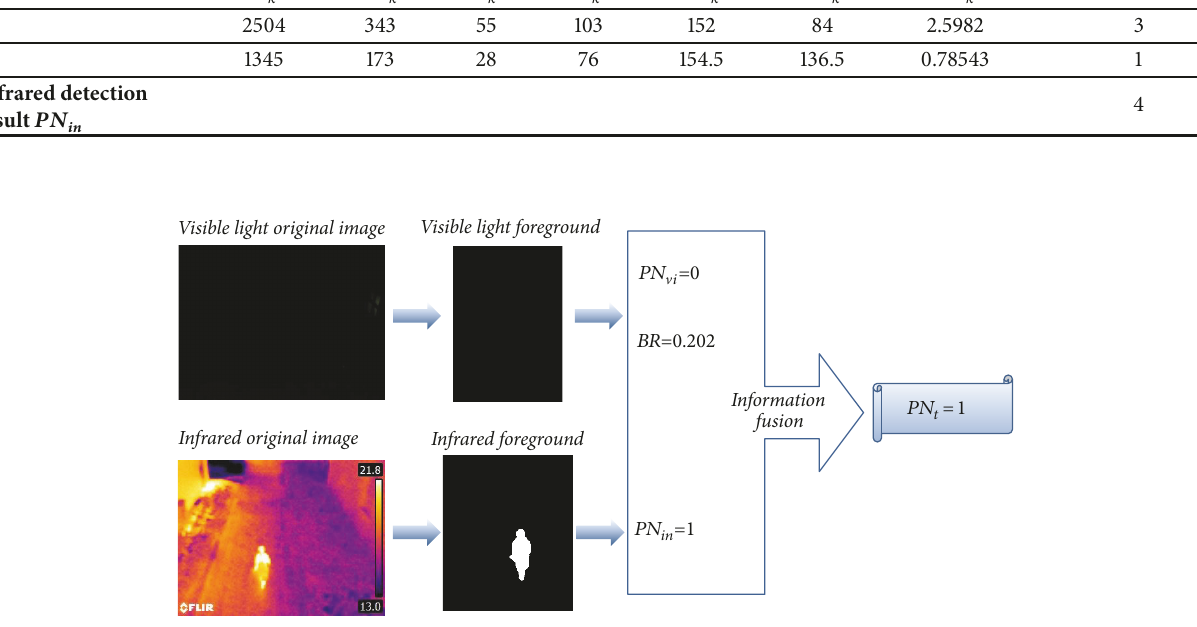
Figure 7: Schematic diagram of information fusion in a night